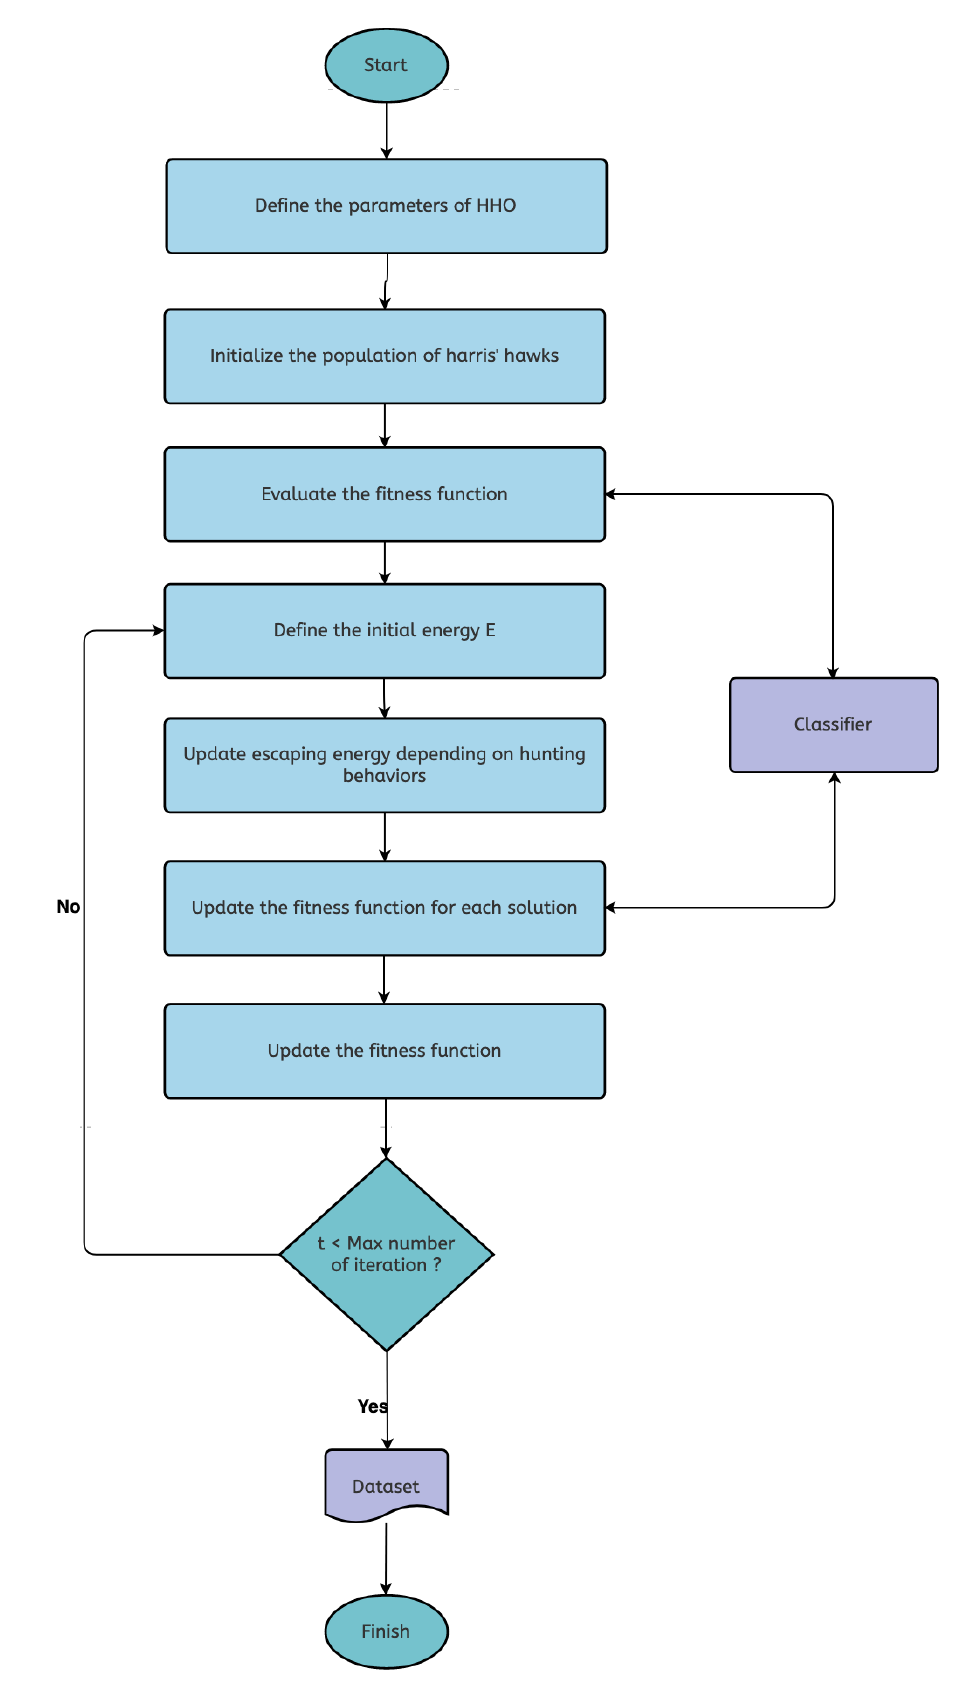
Figure 1. HHO-SVM and HHO-KNN